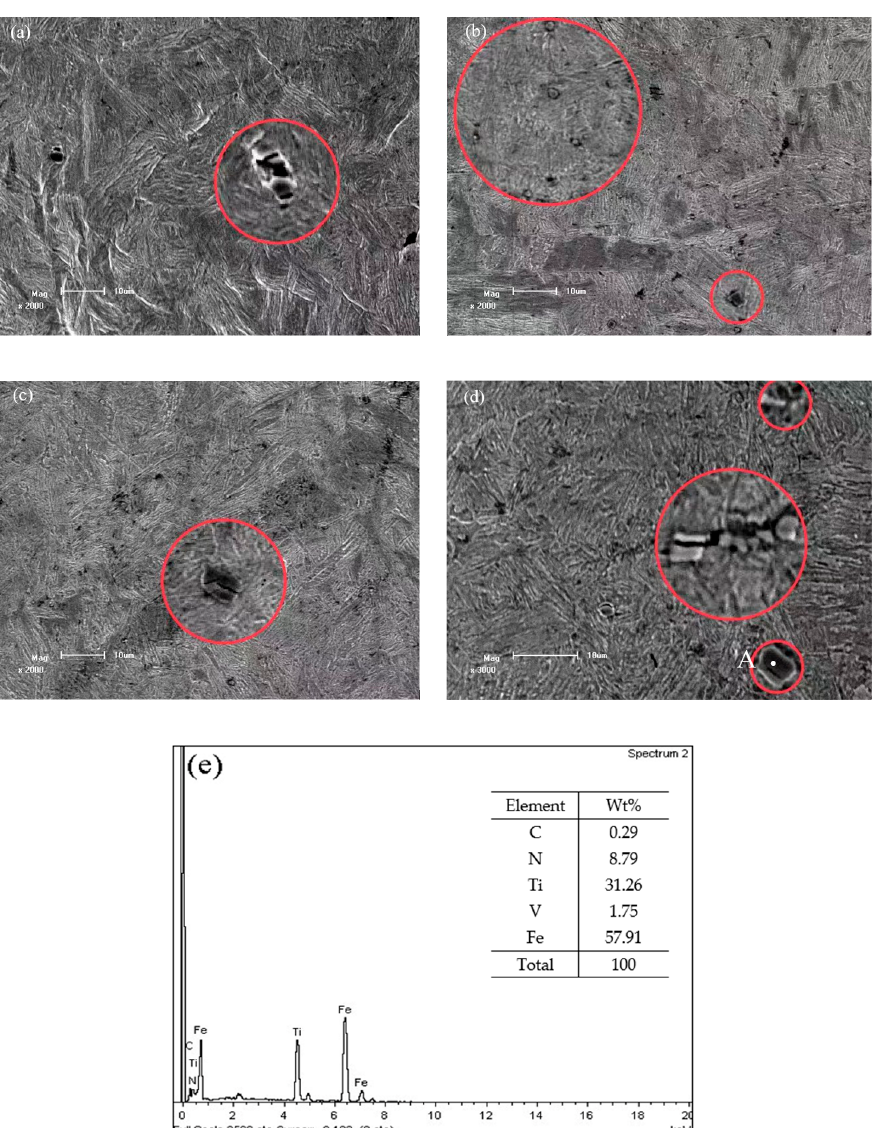
Figure 6. Microstructure characteristics of N2 steel under the uniaxial tensile load: ( a ) 679 N; ( b ) 795 N; ( c ) 945 N; ( d ) 945 N; ( e ) EDS result for Point A (the red circles show the details at an enlarged scale).